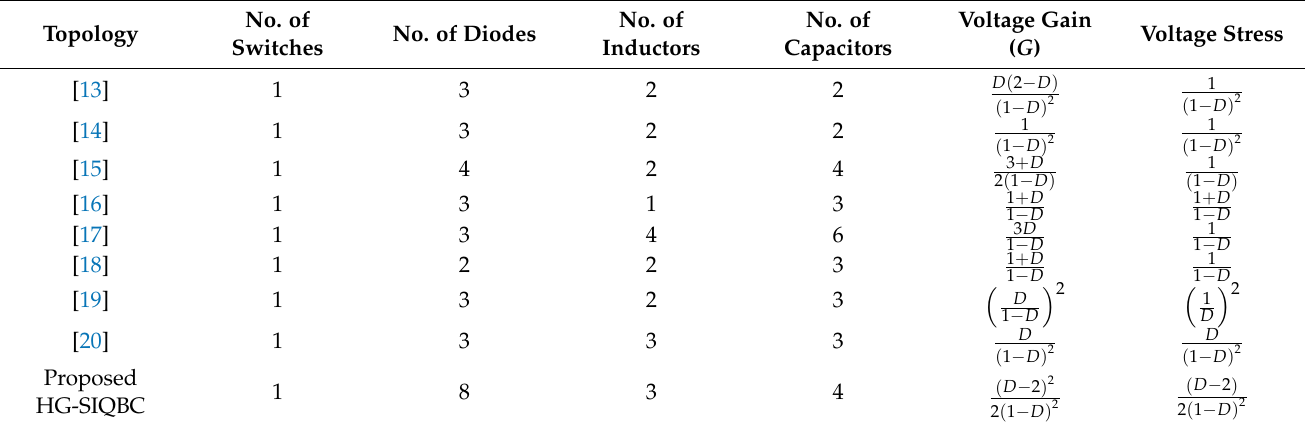
Table 1. Comparison of proposed HG-SIQBC converter with other quadratic